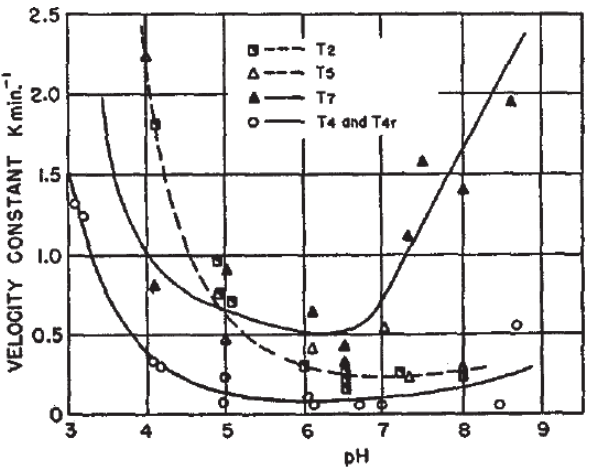
Figure 1. Velocity constants, K minute -1 , as a function of pH for the phages T 2 , T 4 , T 5 , and T 7 at about 26°C.